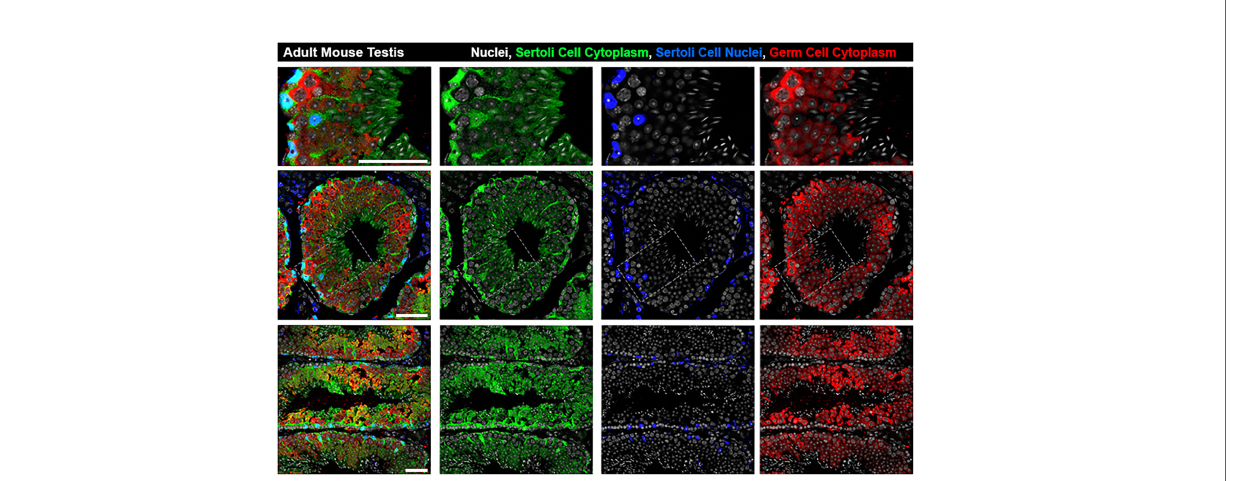
FIGURE 1 | Architecture of Sertoli cells in the adult mouse seminiferous tubule. The bodies of Sertoli cell cytoplasm (green) can be seen engul fi ng germ cells (red) from basal lamina to lumen while Sertoli cell nuclei (blue) are located basally. Top row: zoomed inset from grey boxed region in Middle Row: seminiferous tubule cross section at stage V-VI. Bottom Row: Longitudinal sections showing multiple stages. All scale bars are